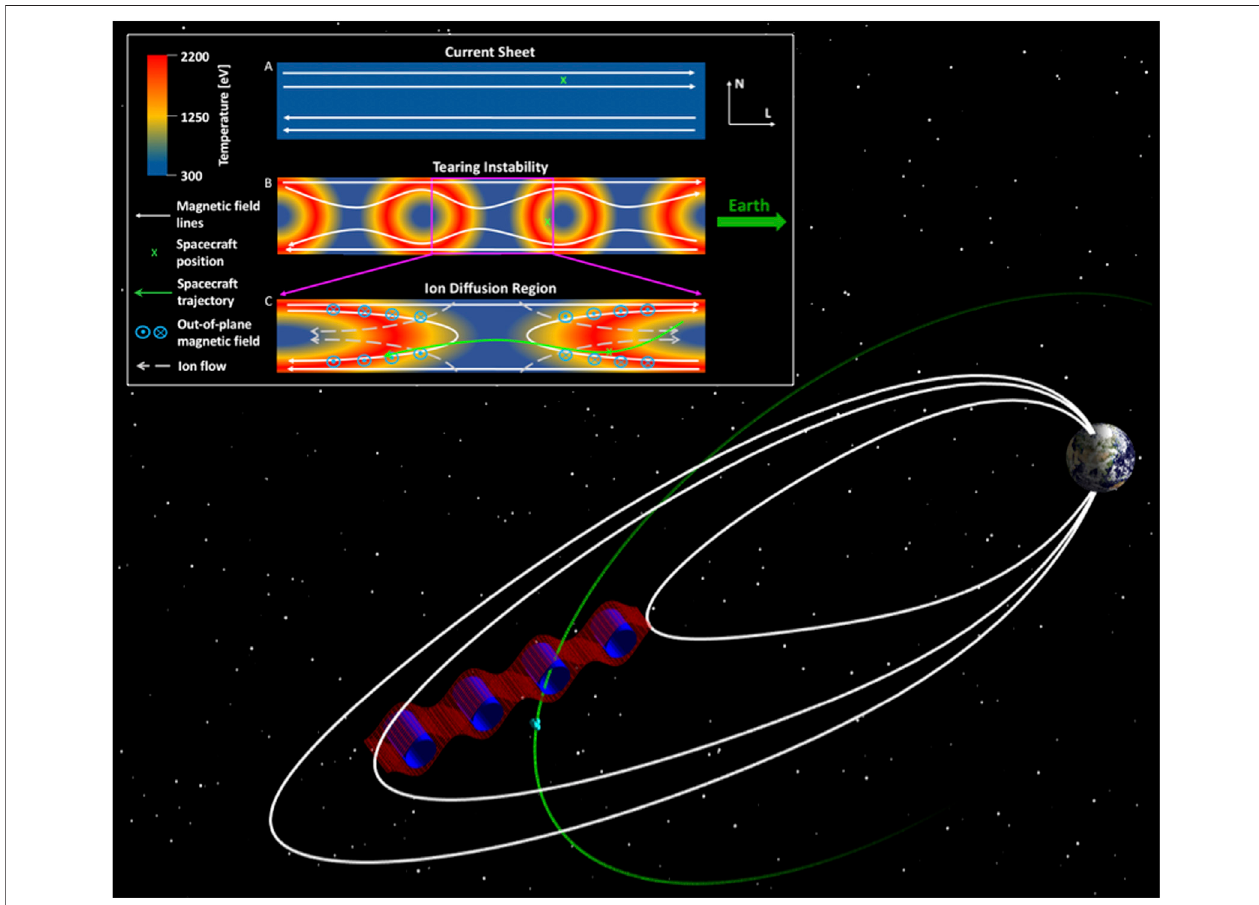
FIGURE 6 | Illustration of the evolution of magnetic fi eld lines from a fl at current sheet into a reconnection site via the tearing instability, with a 3D representation of themagneticislands intheEarth ’ svicinity. Thebackgroundcolours represent thelocalelectron temperature (Luet al.,2019),withthescalesbasedonthetemperatures observed by the C4 spacecraft during the 07/08/2004 tearing event. The white lines represent the magnetic fi eld lines. The three panels correspond to the times A, B, and C in Figure 3 , and the green crosses show the location the C4 spacecraft at each time. The green arrow shows the overall trajectory of the spacecraft across this reconnection region in our case study event. The Hall quadrupole fi eld (blue dots and crosses) and corresponding ion fl ows (dotted grey arrows) are also displayed.